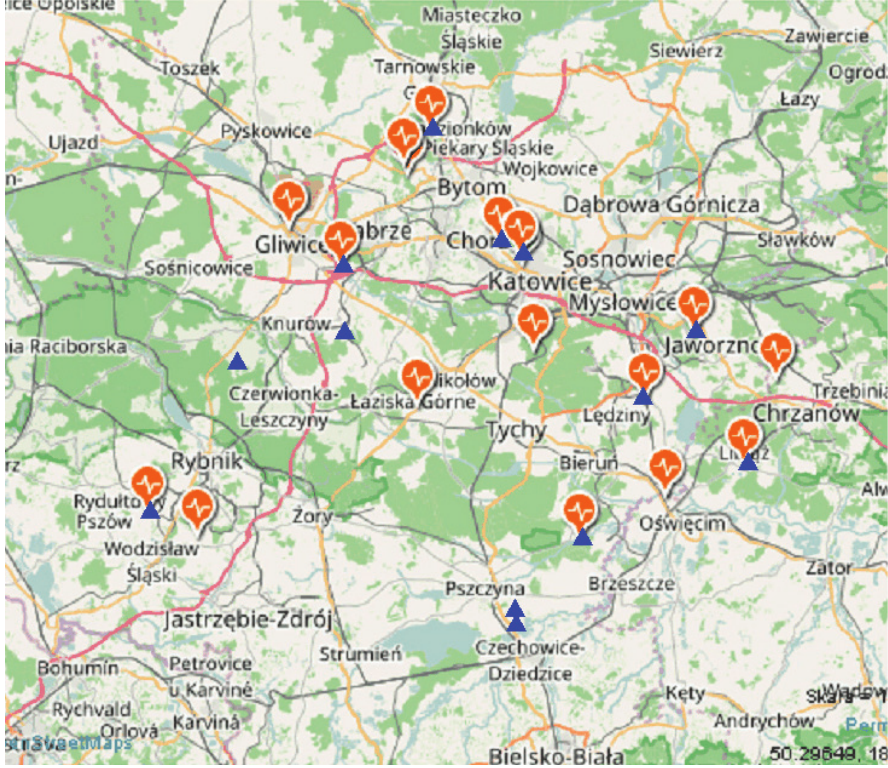
Fig. 2. Location of Upper Silesian Seismological Network in 2015